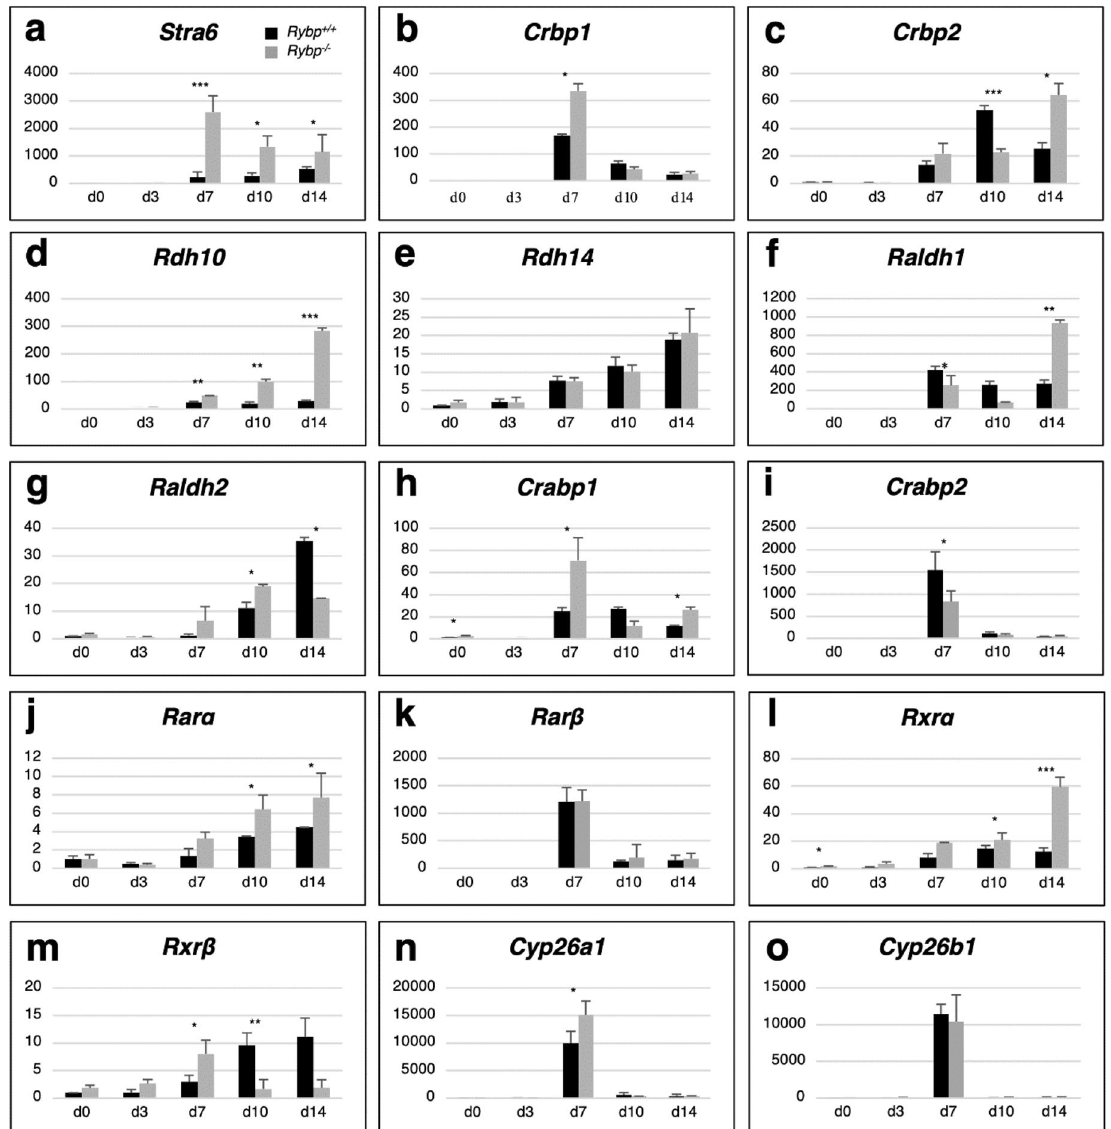
Figure 2. Members of the RA signaling pathway exhibit elevated expression level in the absence of Rybp . Relative gene expression changes of membrane receptor ( a ) Stra6 ; intracellular retinol binding complex members ( b ) Rbp1 , ( c ) Rbp2 ; and retinoid converting enzymes ( d ) Rdh10 , ( f ) Aldh1a1 , ( g ) Aldh1a2 by qRT-PCR showed altered expression in Rybp −/− neural cultures in comparison to wild type, while there was no significant difference in ( e ) Rdh14 expression in the two cell lines. Relative gene expression analysis of intracellular RA binding complex members ( h ) Crabp1 , ( i ) Crabp2 ; nuclear RA receptor complex members ( j ) Rarα , ( l ) Rxrα , ( m ) Rxrβ and RA degrading enzyme ( n ) Cyp26a1 by qRT-PCR showed altered expression in the Rybp −/− neural cultures in comparison to the wild type but there was no difference in ( k ) Rarβ and ( o ) Cyp26b1 expression between the two cell lines. The expression of the indicated markers was normalized to Hprt level. Means are standard deviation ± SD. Values of p < 0.05 were accepted as significant (* p < 0.05; ** p < 0.01; *** p < 0.001). Statistical method: t test type 3, n = (Fig. 2k). The expression of both Rxr members showed a gradually increasing level in the Rybp −/− cells. Rxrα level was higher at all examined time points in the Rybp −/− cell line and its expression kinetics did not decline by the end of differentiation as it did in the case of the wild type (Fig. 2l). Rxrβ level was also higher in the Rybp −/− cells, but compared to the Rxrα, it showed higher mRNA level at d0, d3 and the highest at d7 (after atRA treatment) (Fig. 2m). The mRNA level of RA degrading enzyme Cyp26a1 was strongly induced by atRA treatment (d7), and the level of induction was more pronounced in the Rybp −/− compared to the wild type (Fig. 2n). There were no differences in Cyp26b1 expression in the two cell lines (Fig. 2o). These results showed that the expression of all examined genes, which are responsible for retinoid binding and metabolism in the cytoplasm ( Rbp1 , Rbp2, Rdh10, Aldh1a2 and Crabp1) was higher in the Rybp −/− cells from neuroectoderm formation (after day 4) until the last day (d14) of in vitro neural differentiation. Notably, the